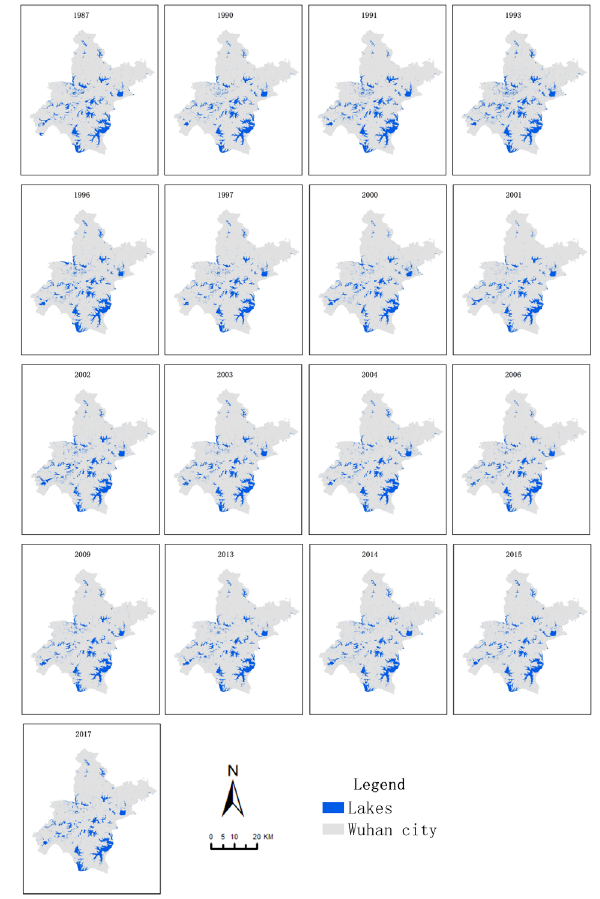
Figure 3 . Distribution of lakes from 1987 to 2019.